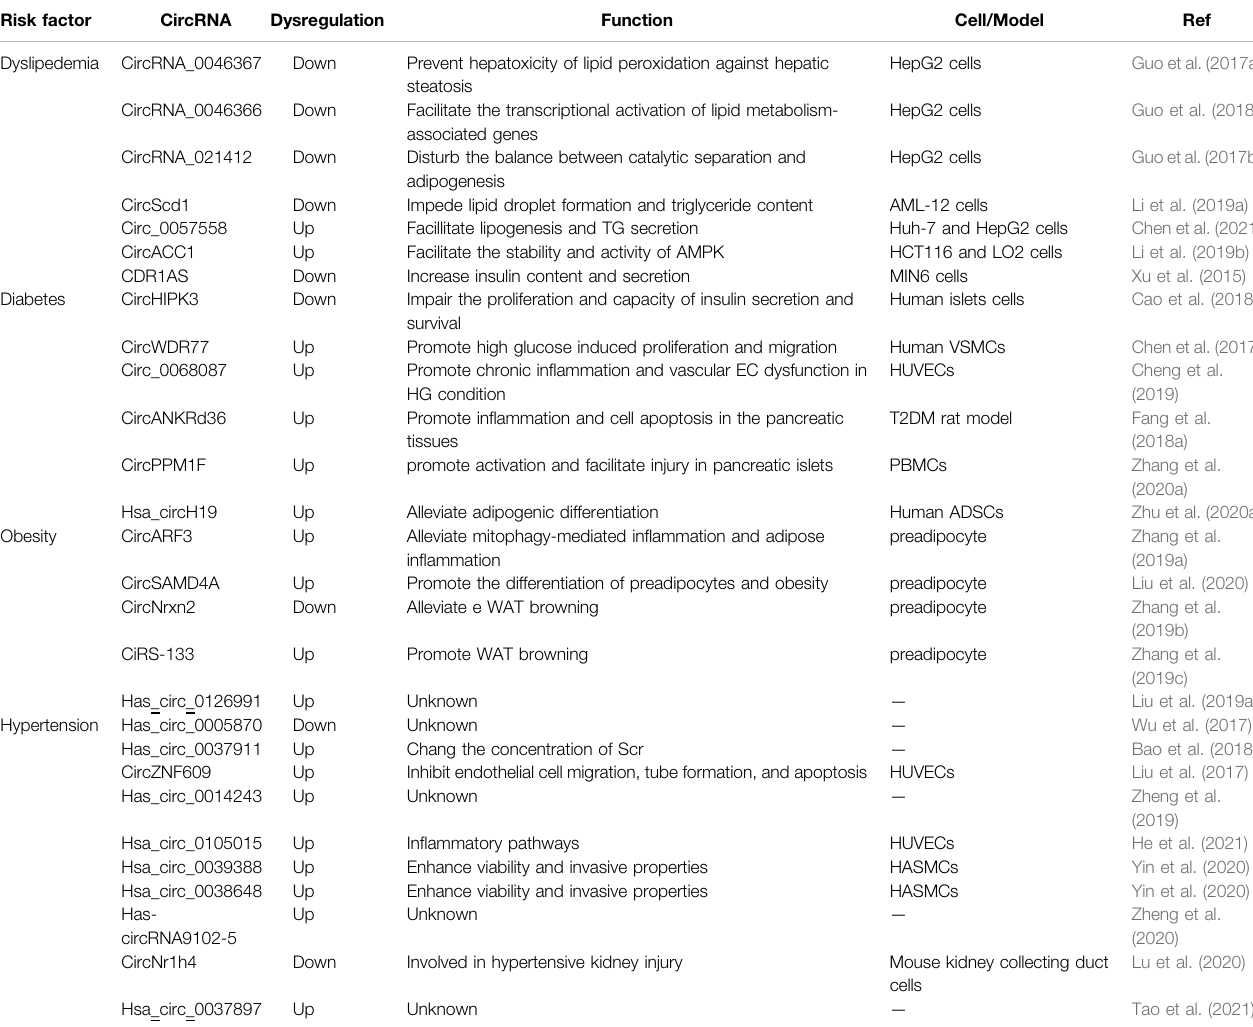
TABLE 1 | CircRNAs are involved in the development of AS risk